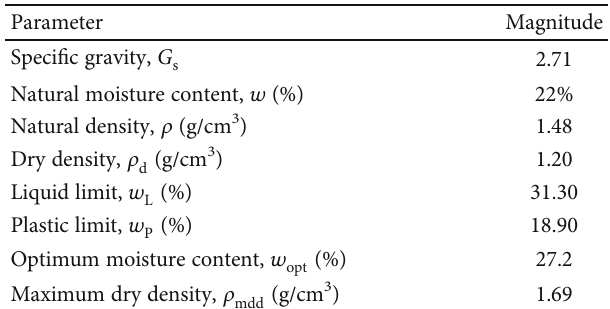
Table 1: Material parameters of the